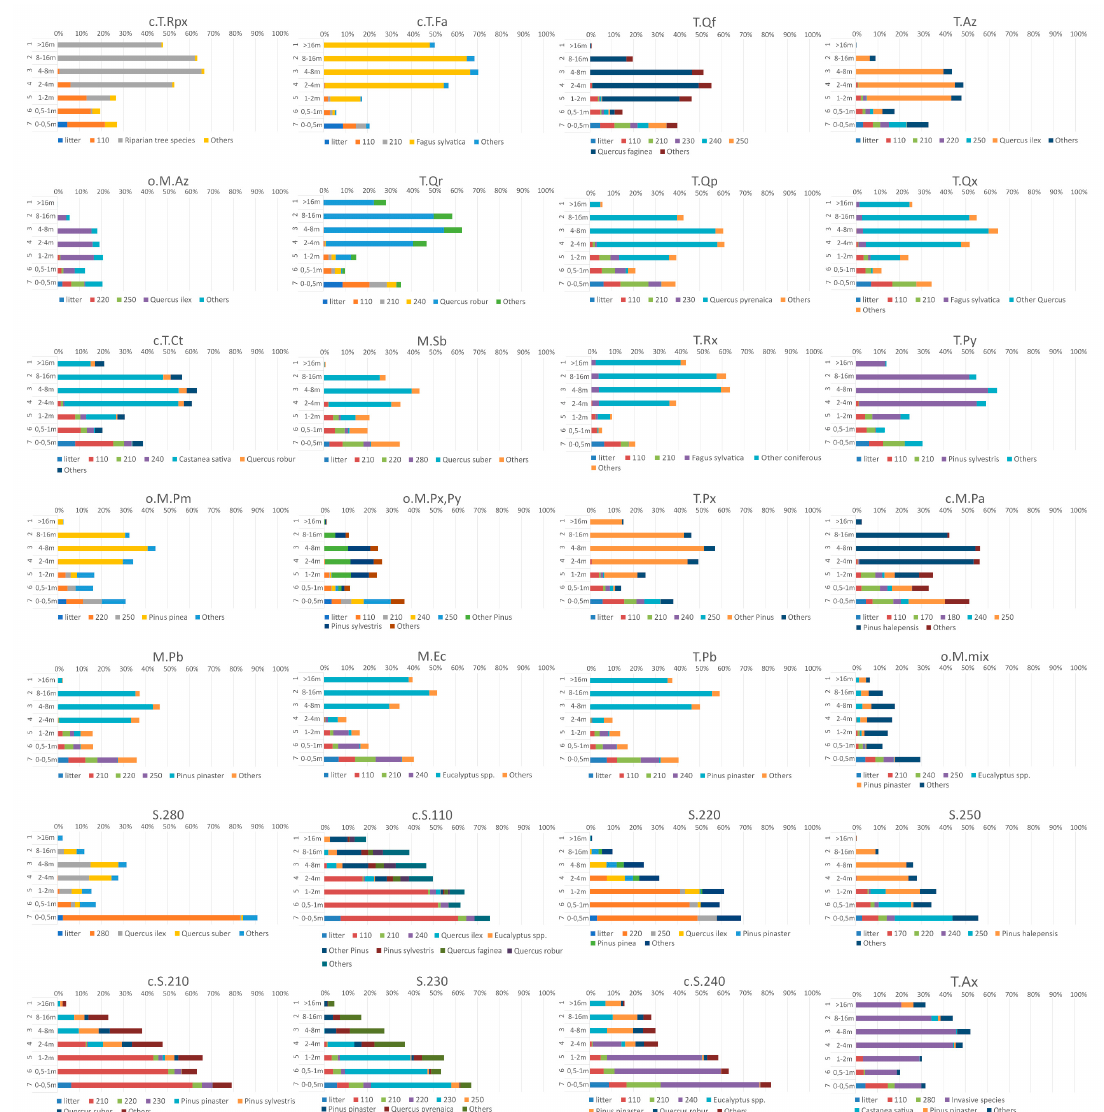
Figure 5. Total coverage for each vertical layer (seven strata) for each forest type. Layer seven includes litter cover percentage.